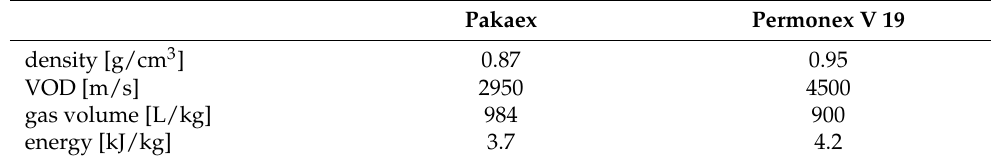
Table 1. Specifications from the manufacturer of Pakaex and Permonex V19 [4,6,14,17,18,22].